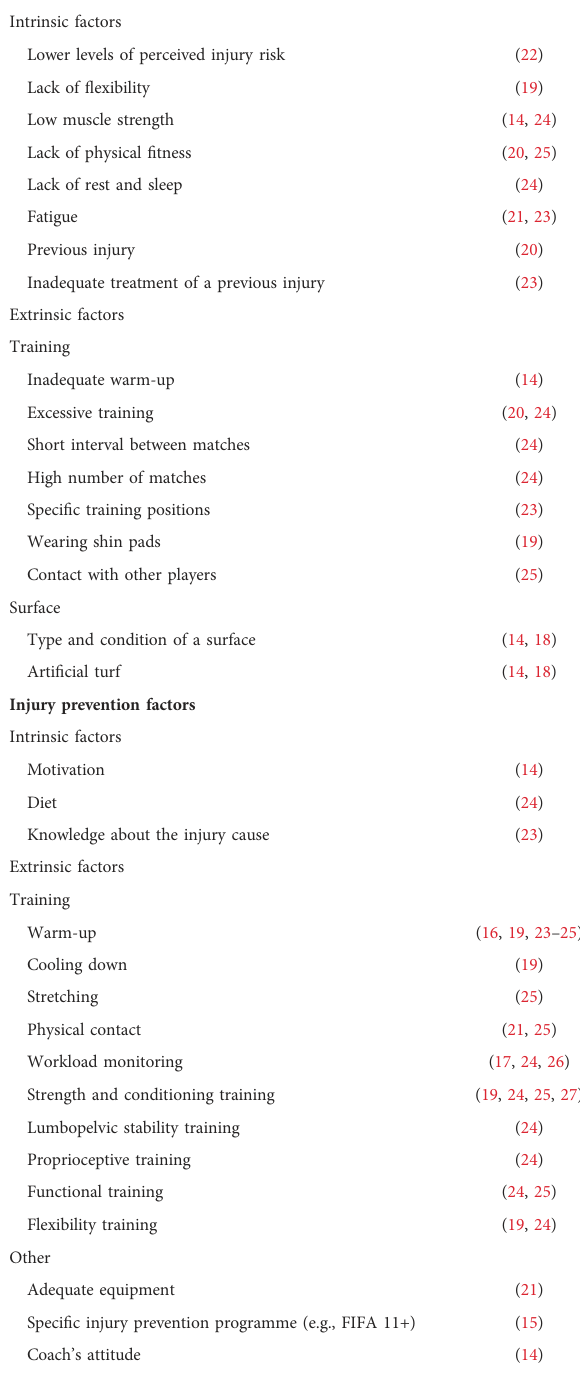
TABLE 3 Summary of injury risk and prevention